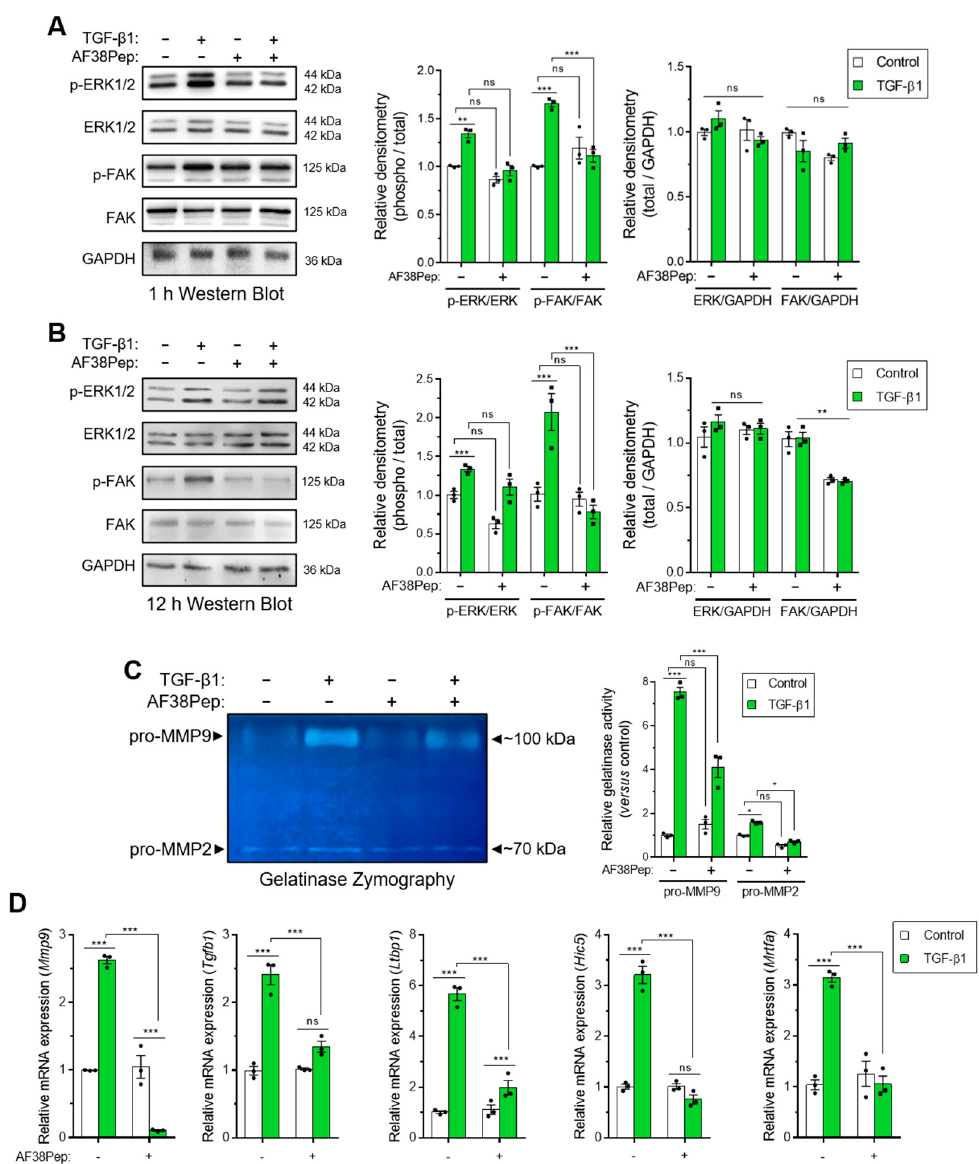
Figure 8. Evaluation of blocking peptide capacity to inhibit integrin α 4 β 1 signaling and